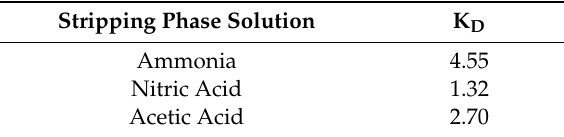
Figure 2. E ff ect of type of stripping agent on extraction e ffi ciency. Figure 2. Effect of type of stripping agent on extraction efficiency . Table 3. Distribution coe ffi cient of di ff erent stripping phase Table 3. Distribution coefficient of different stripping phase solutions.